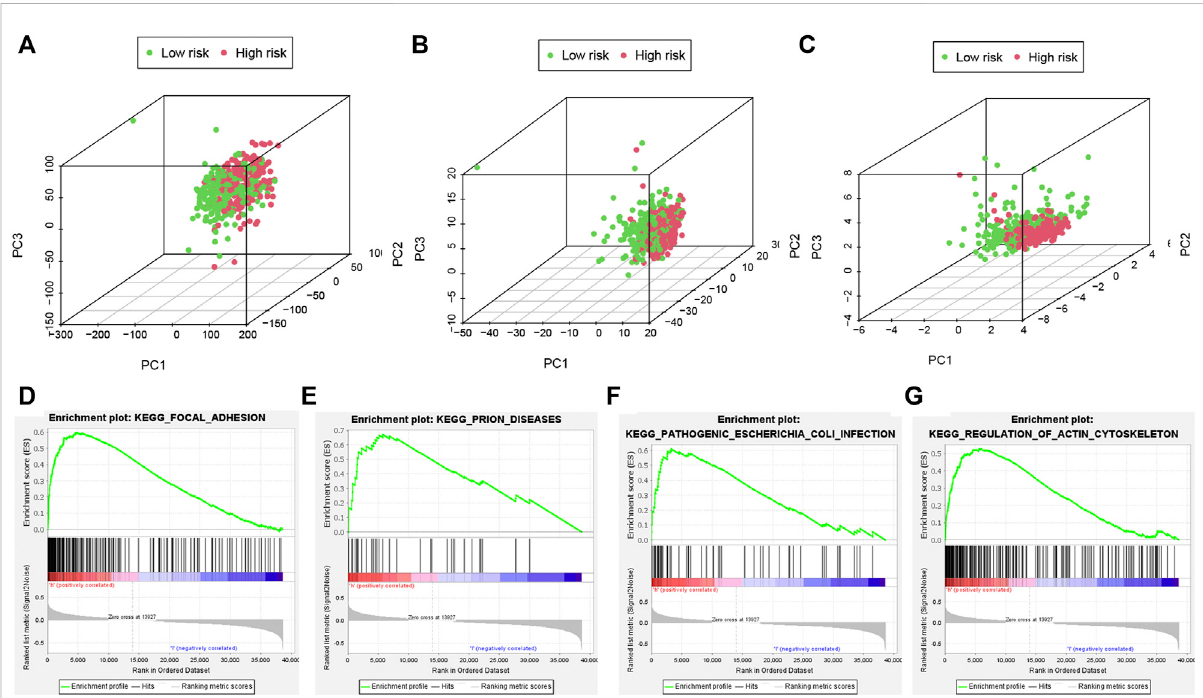
FIGURE 7 PCAanalysesandimportantpathwaysoftheriskmodel.ThePCAvisualizedthedifferentdistributionpatternsofpatientsin (A,B) :allpyroptosis- related genes, lncRNAs and (C) 6 pyroptosis-related lncRNAs using 3D scatterplot. PCA analyses show the risk model could clearly distinguish the two risk groups (high and low) of patients. (D – G) : GSEA analysis showed important pathways in gene expression of two risk groups. PCA, principal component analysis; GSEA, Gene Set Enrichment